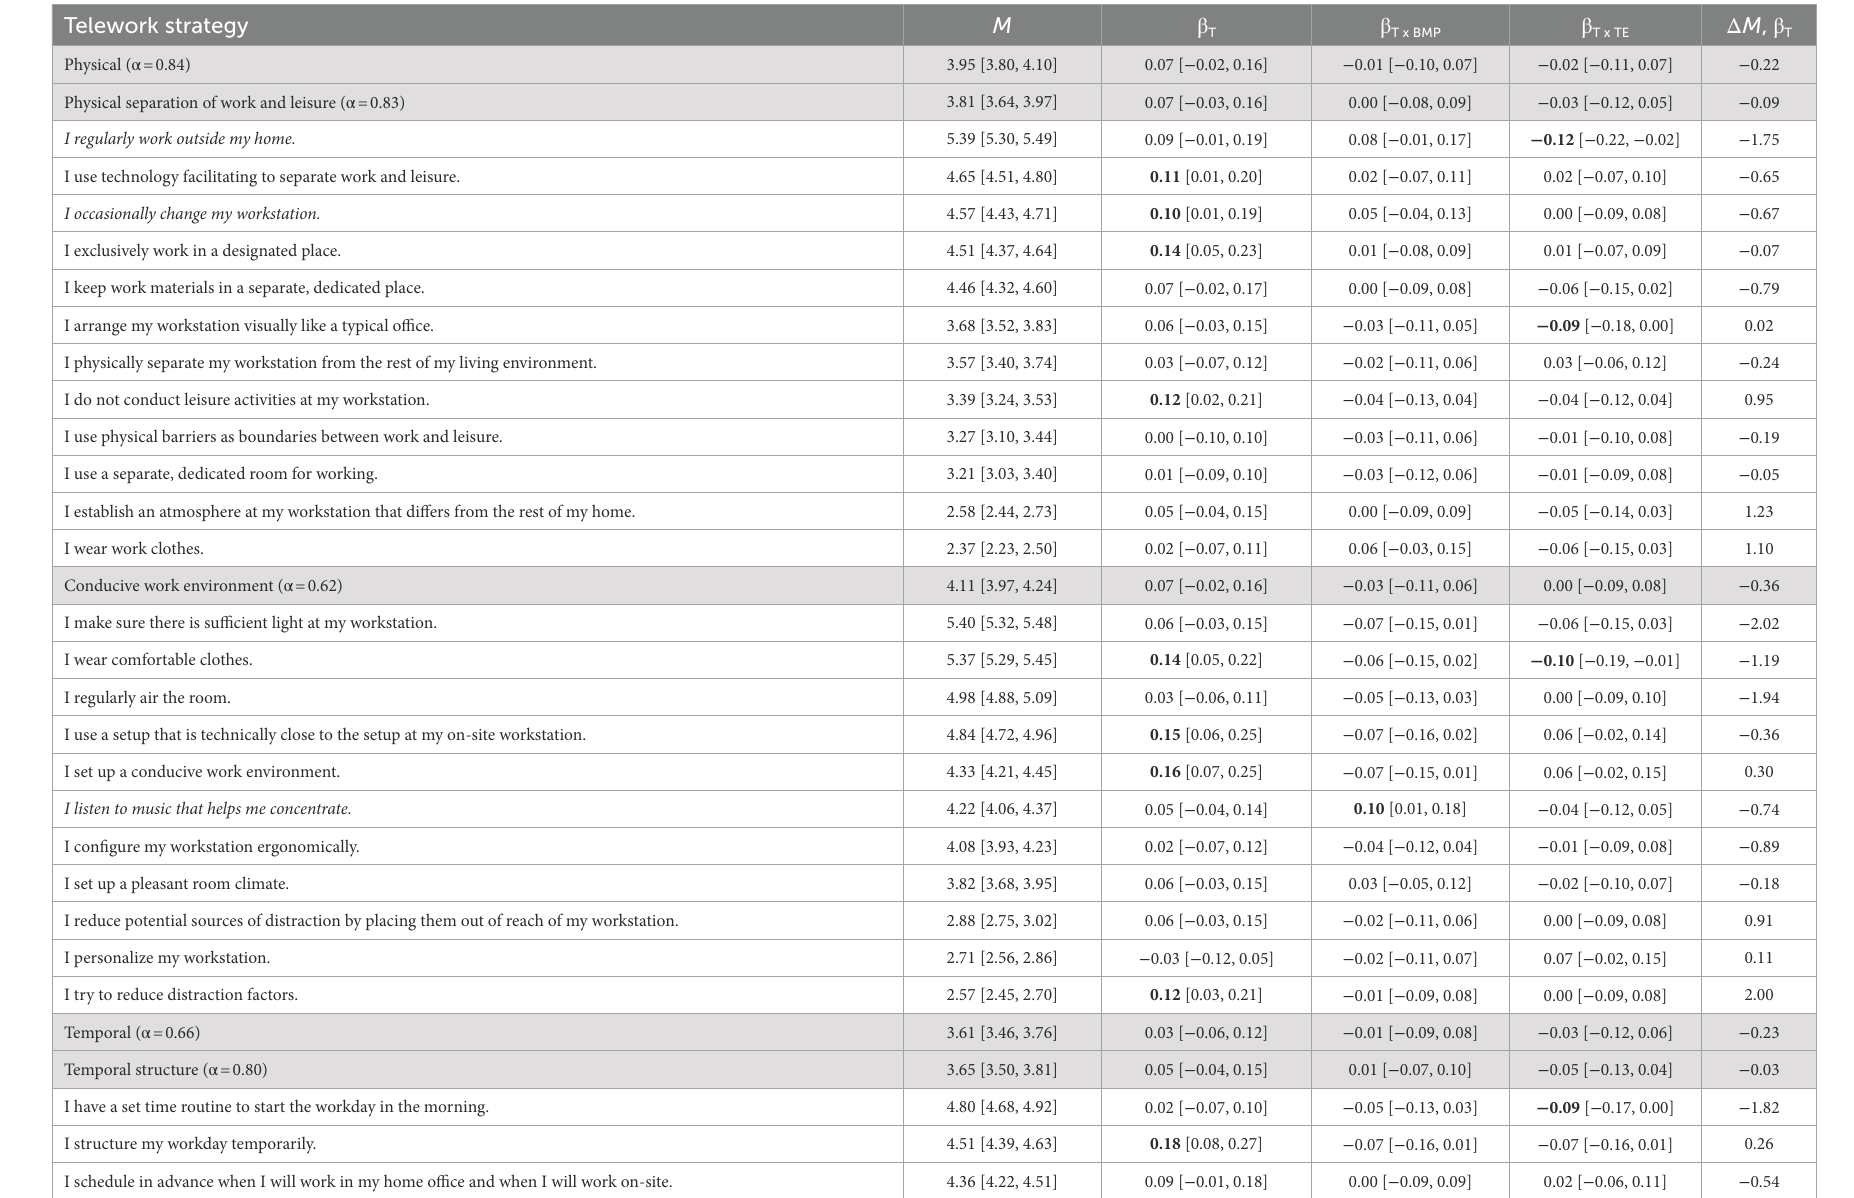
TABLE 1 Telework strategies’ implementation, multiple linear regression results of telework strategies and interaction effects with boundary management preferences and telework experience predicting job performance, and divergences between telework strategies’ implementation and association with job performance. Telework